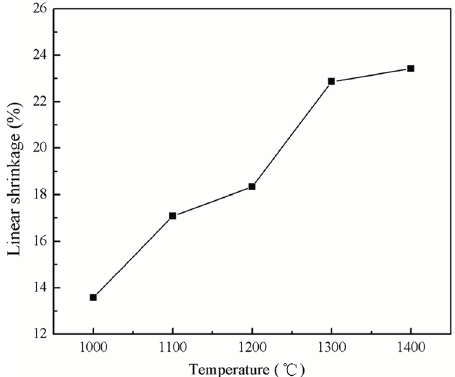
Fig. 2 Linear shrinkage of gel powder wafers after heat treatment.